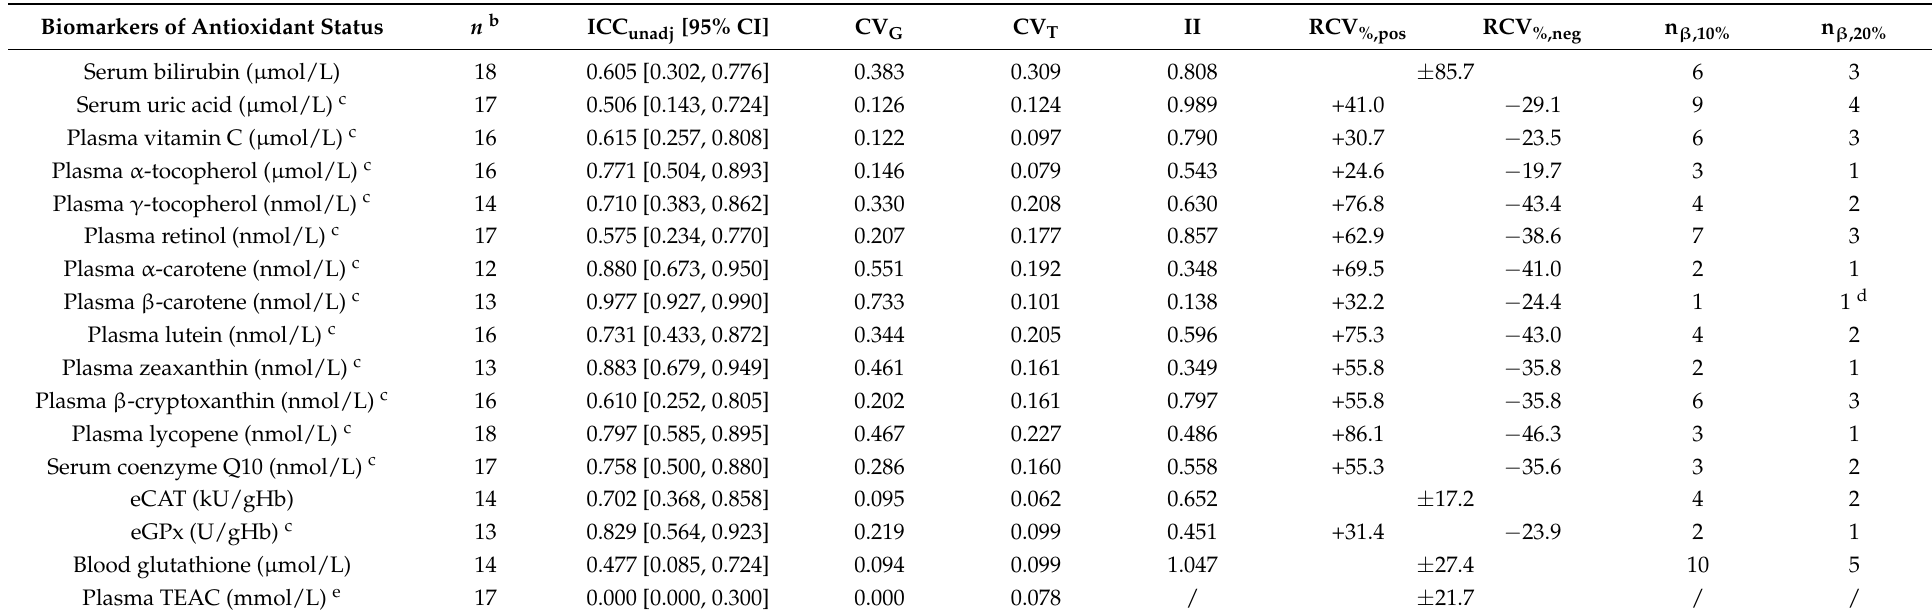
Table 3. Indicators of reliability and inter- and intra-individual variability for each antioxidant biomarker in premenopausal women after excluding subjects with conditions that may impair or influence biomarker status a